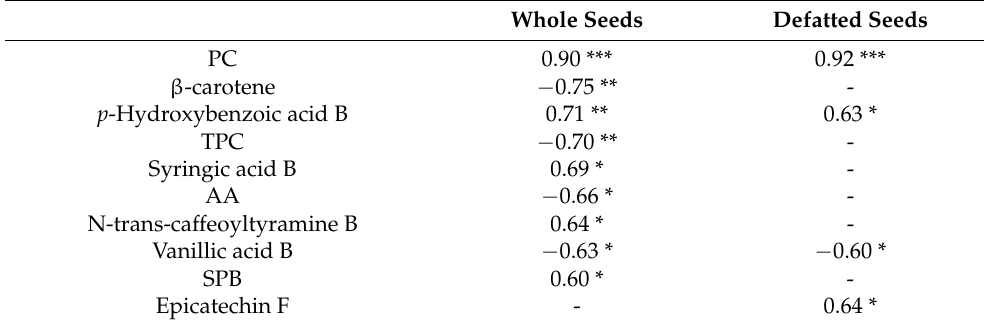
Table 5. Pairwise correlations between chemical compositions of seeds (whole and defatted) and precipitations (April–September) of the two